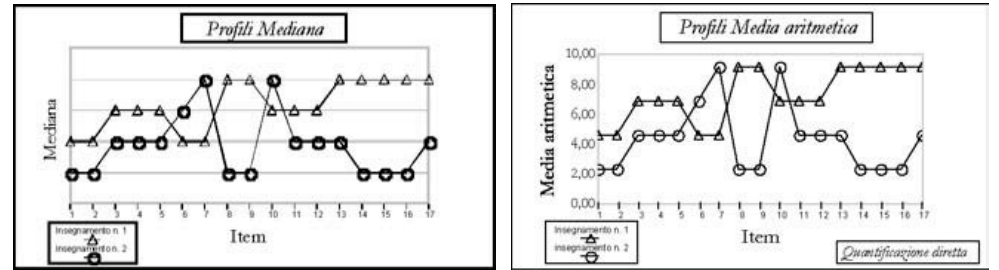
Figura 1 – Rappresentazione grafica dei profili di due insegnamenti – (le 17 domande considerate sono quelle inserite nelle Categorie A , B , C e D in precedenza